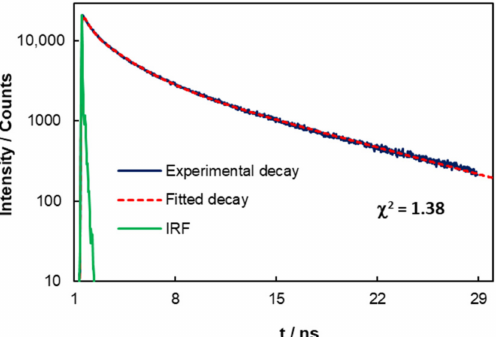
Figure 4. Intensity decay of aqueous dispersions of C-dots (HTC) excited at 340 nm and observed at 434